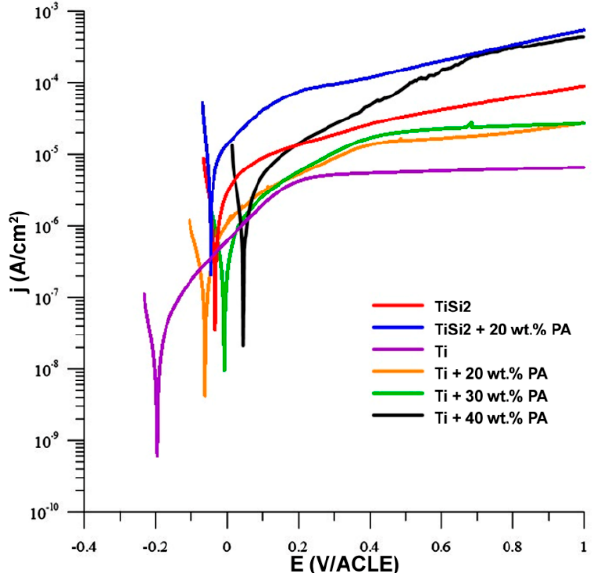
Figure 10. Anodic polarization in simulated body fluid (SBF).